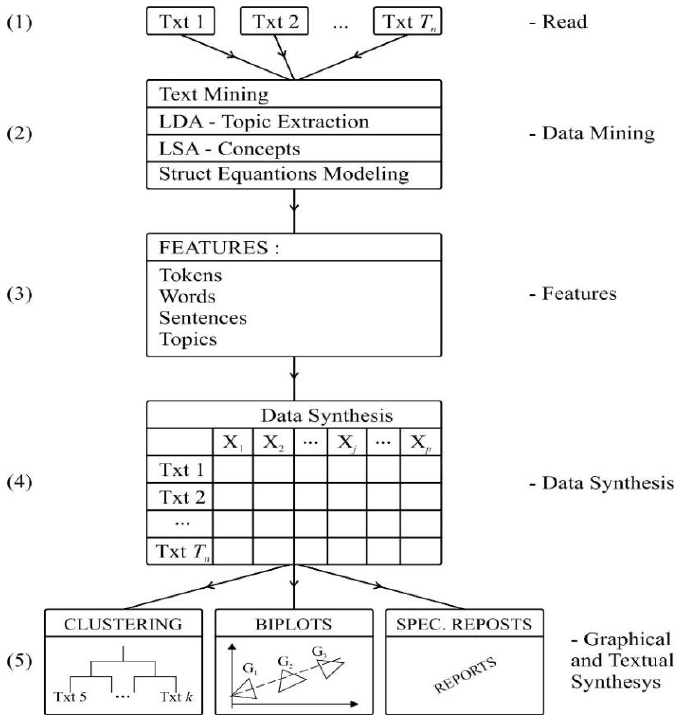
Figure 1. Diagram illustrating the process’s main tasks to generate the graphical synthesis of texts.